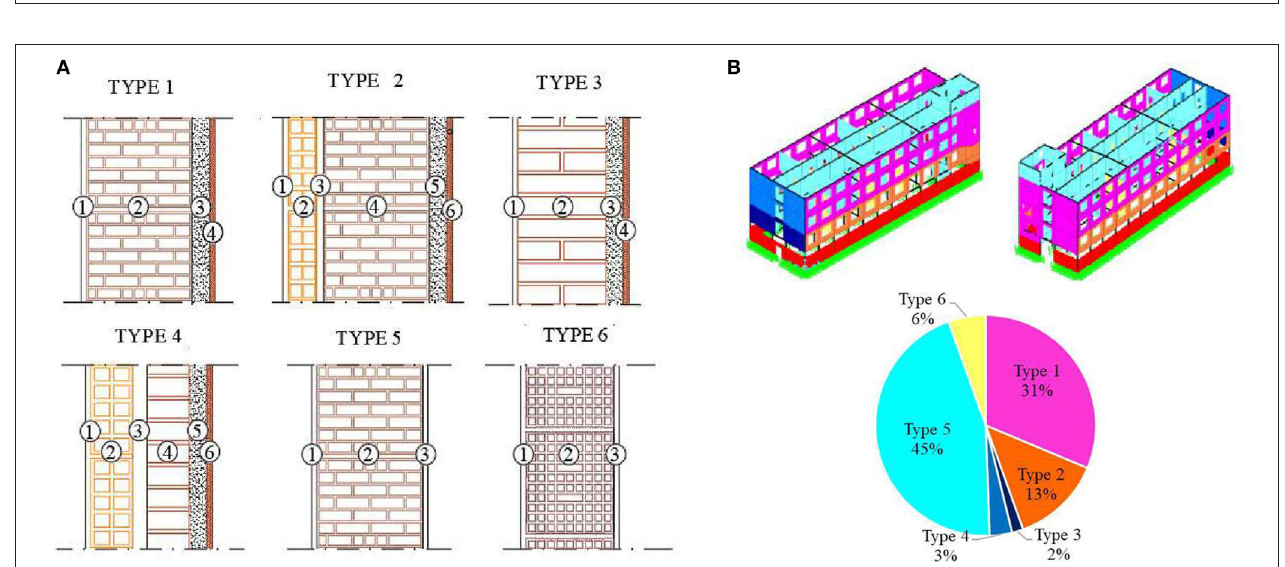
FIGURE 4 | External and internal infill wall typology (A) and distribution in the model (B) .